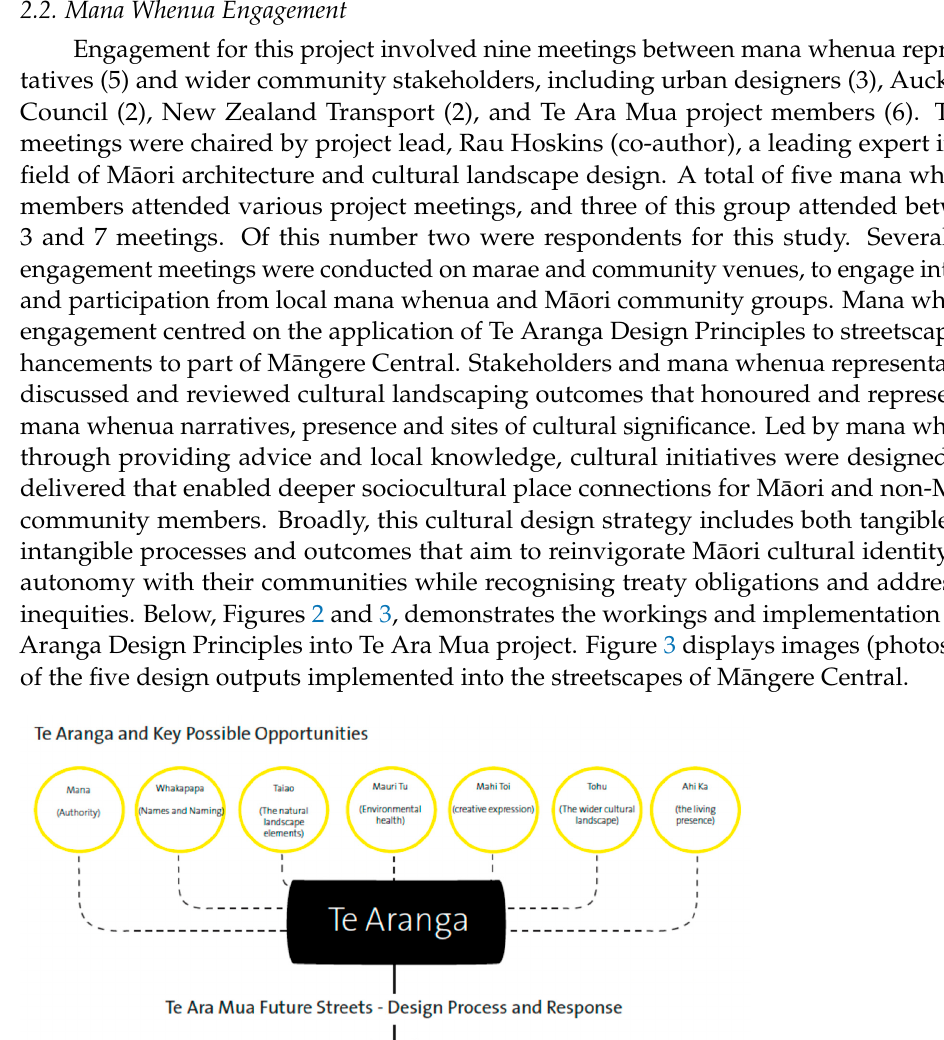
Figure 1. Map of M ā ngere—Te Ara Mua project intervention area for mana whenua engagement (Source: Google Maps & Figure 1. Map of M¯angere—Te Ara Mua project intervention area for mana whenua engagement TAMFS Project Image) . (Source: Google Maps & TAMFS Project Image). 2.2. Mana Whenua Engagement Engagement for this project involved nine meetings between mana whenua repre-